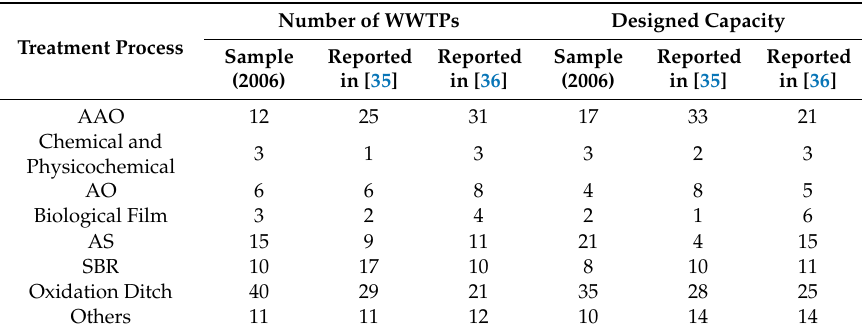
Table 2. Shares of treatment processes by number of treatment plants, and total designed capacity in the sample and the entire sector, (percent).